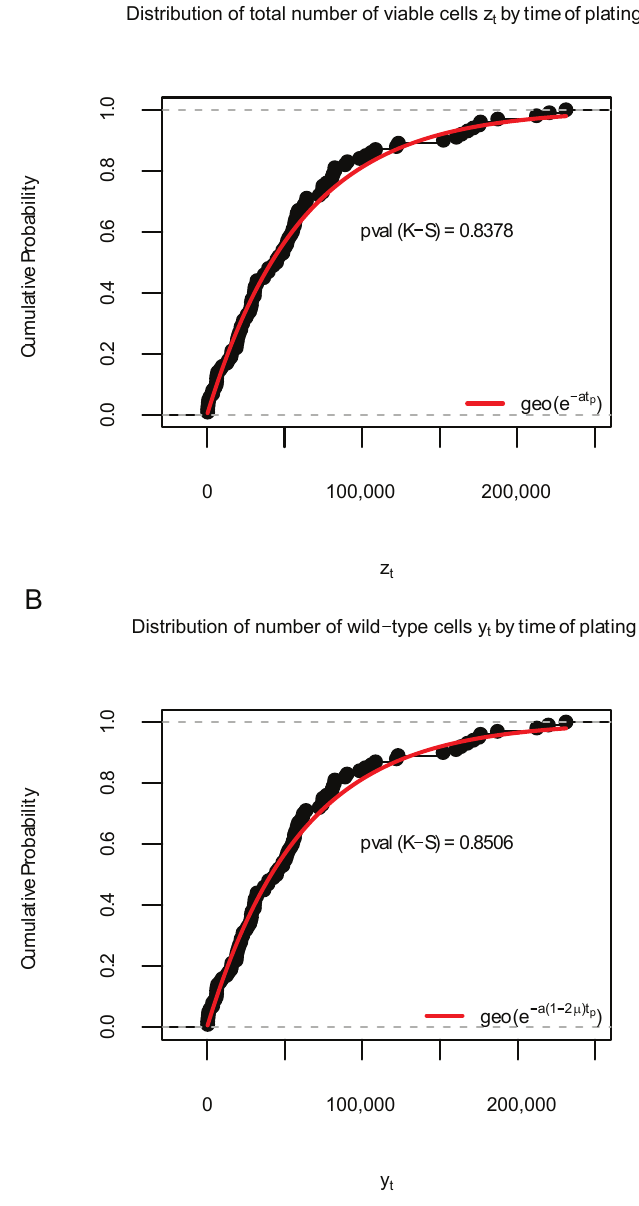
Figure 3. Distribution of 100 data samples generated by SimuBP in Simulation S1a. ( A ): Empirical cumulative distribution function (ECDF) of the total number of viable cells z t when the time of plating t p = 11. ( B ): ECDF of the number of wild-type cells y t when t p = 11. The red curves represent the cumulative distribution function of the theoretical geometric distributions in comparison. The Kolmogorov–Smirnov (K-S) test p -values are shown under the ECDF